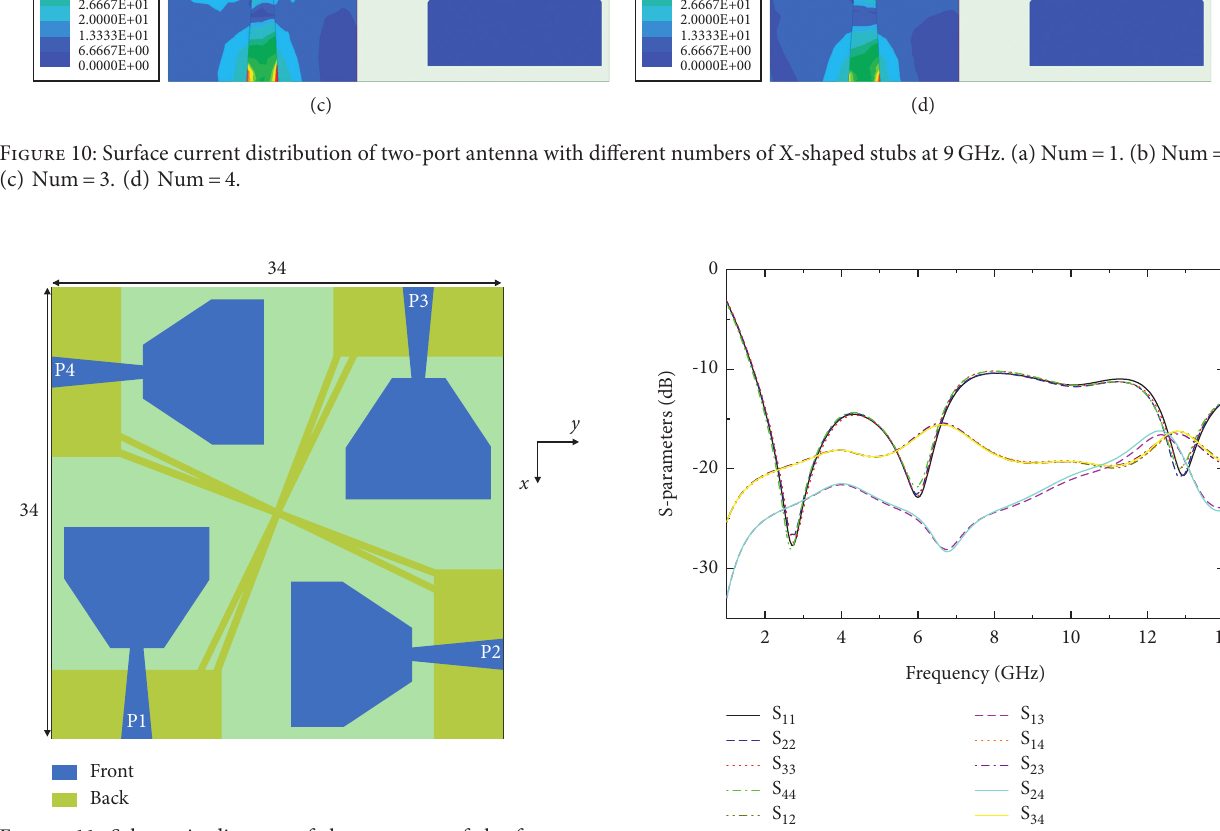
Figure 12: S -parameter simulation results of four-port